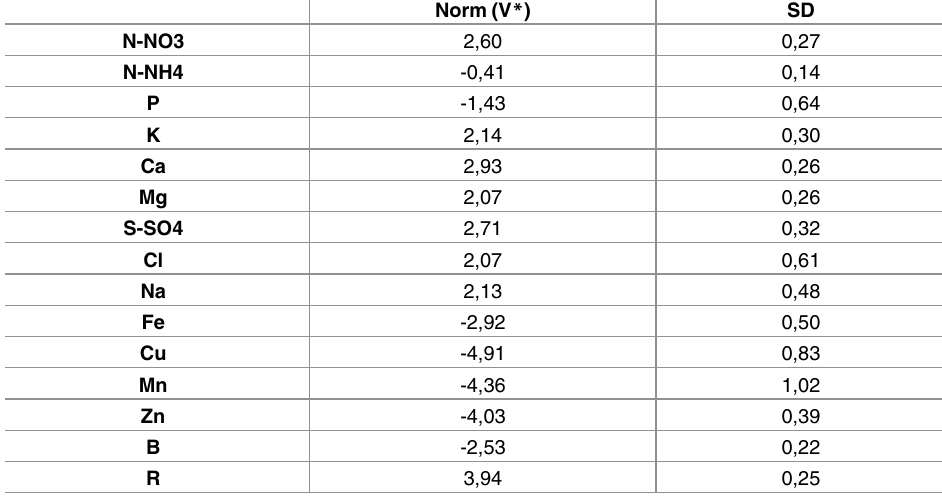
Table 3. CND norms from analysis of saturated soil extracts(SSE) for Rose sp . growing in the Bogota´ Plateau,